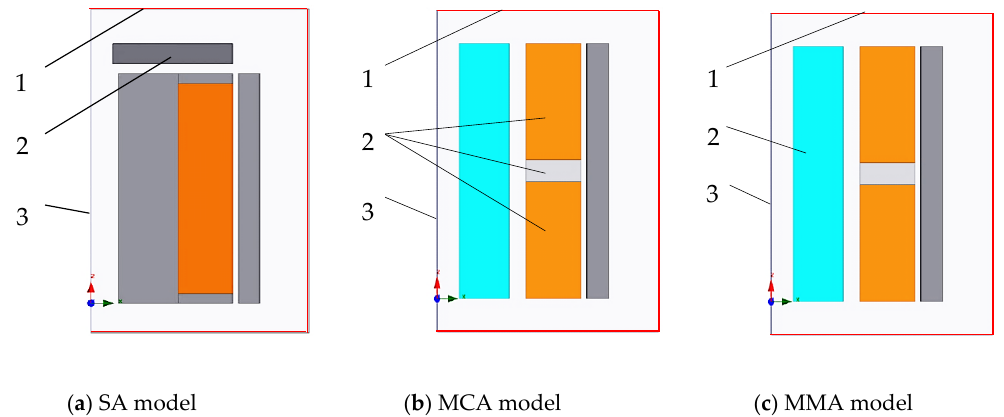
Figure 8. Boundary conditions imposed on 2-D symmetric models. ( a ) Balloon boundary; ( b ) movable part; and ( c ) symmetric axis.